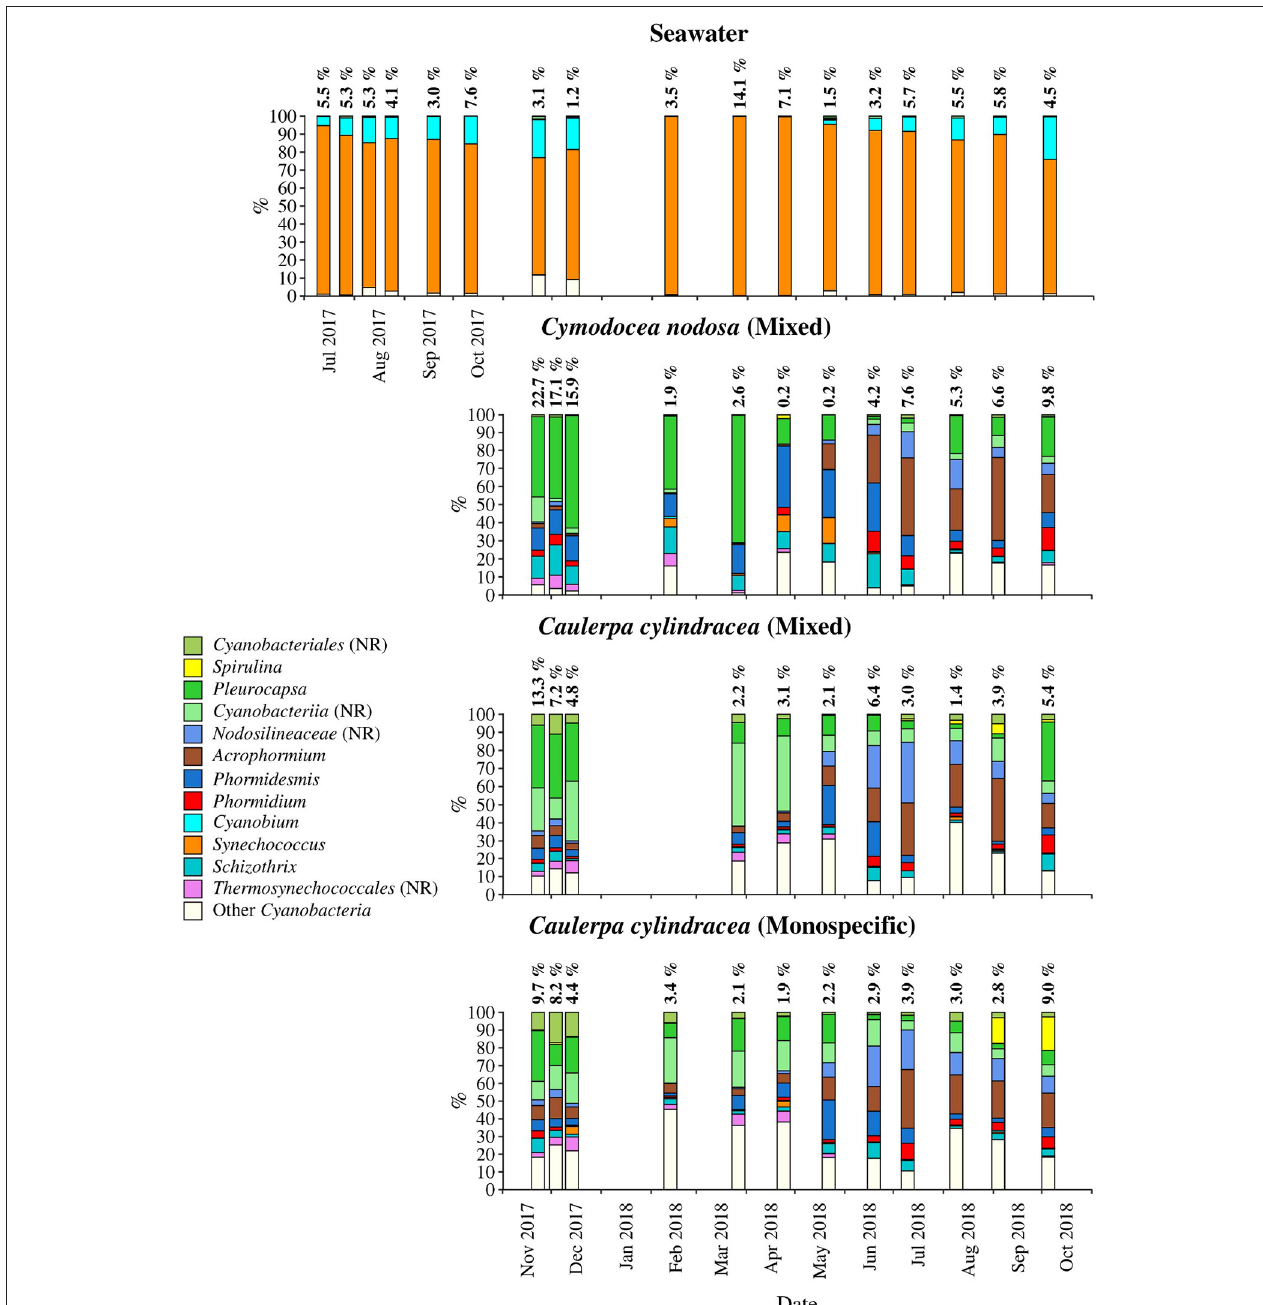
FIGURE 5 | Taxonomic classification and relative contribution of the most abundant ( ≥ 1%) cyanobacterial sequences on the surfaces of the macrophytes C. nodosa (mixed settlement) and C. cylindracea (mixed and monospecific settlement) and in the ambient seawater. The proportion of cyanobacterial sequences in the total bacterial and archeal community is given above the corresponding bar. NR, no relative (sequences without known relatives within the corresponding group).